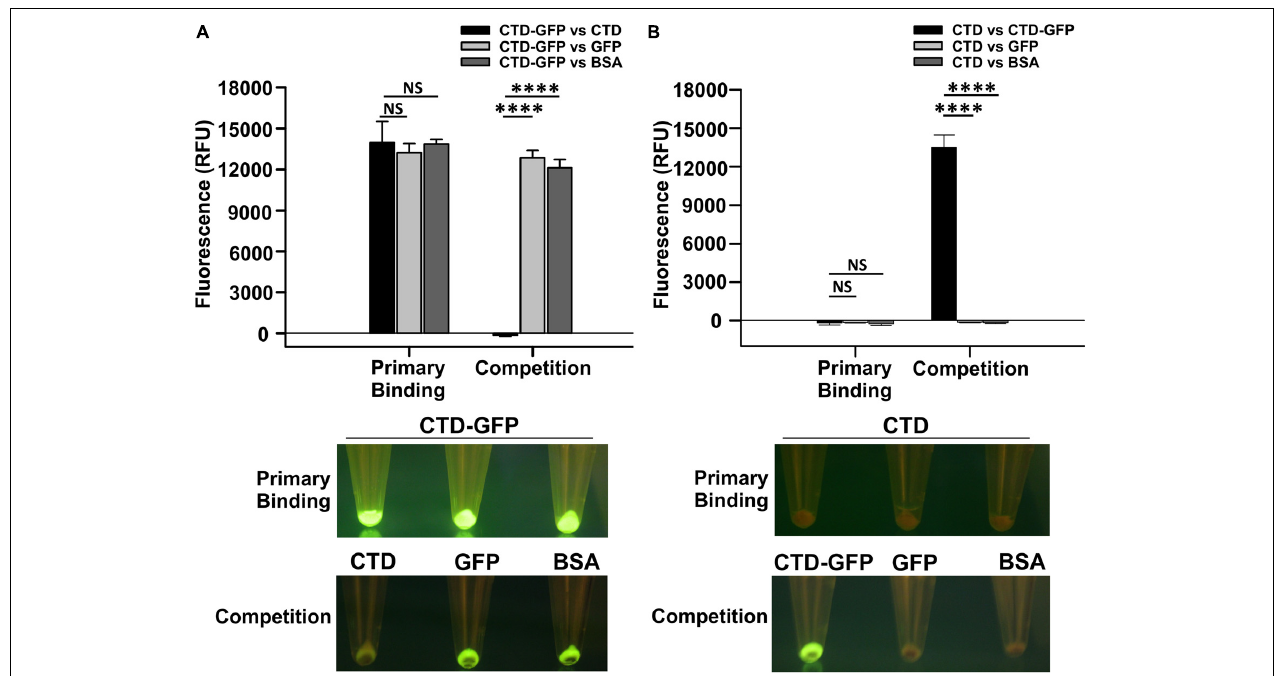
FIGURE 2 | Qualitative and quantitative assessment of CTD binding to M. smegmatis cells. (A) The relative fluorescence obtained for M. smegmatis cells bound to CTD-GFP before (Primary binding) and after competitor addition (Competition). Competitors used are CTD, GFP, and BSA. (B) The relative fluorescence obtained for M. smegmatis cells bound to CTD before (Primary binding) and after competitor addition (Competition). Competitors used are CTD-GFP, GFP, and BSA. In both A and B , the data represent an average of three independent experiments with error bars denoting the standard deviation ( p -value analysis: ∗∗∗∗ , < 0.0001; NS, not significant). In both A and B , the bottom panels show the image of fluorescing cell pellet obtained after illuminating it with a blue light ( ∼ 470 nm) source before and after the